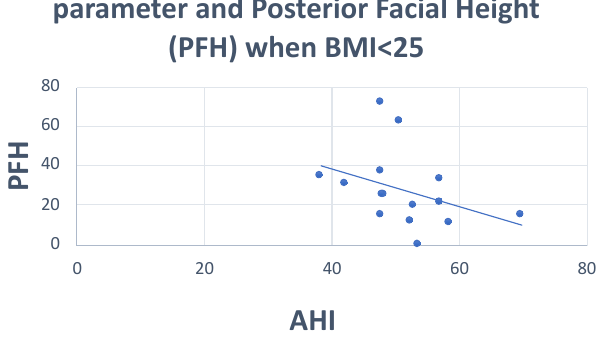
Figure 2. Scatter plot defining the relationship between AHI and posterior facial height. r = − 0.36.